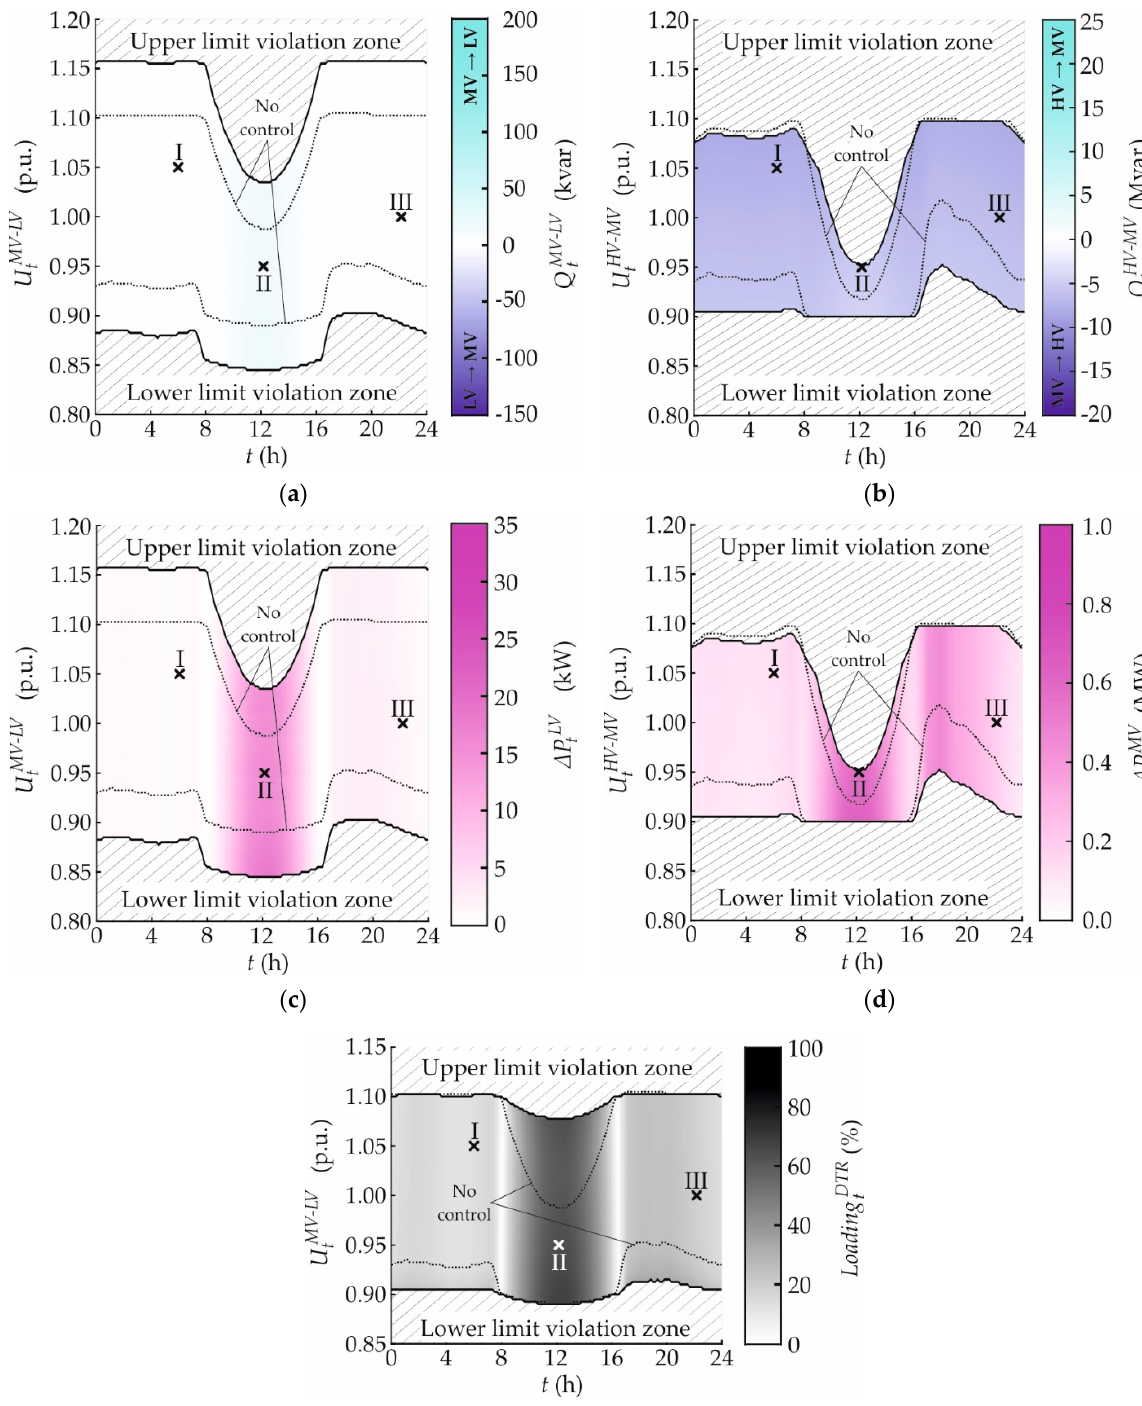
Figure 20. Daily behavior of the test link chain for various boundary voltages, the X ( U ) local control, and CP_ Q -Autarky: ( a ) reactive power exchange over the MV − LV boundary (rural LV_Link-Grid); ( b ) reactive power exchange over the HV − MV boundary; ( c ) active power loss within the rural LV_Link-Grid; ( d ) active power loss within the MV_Link-Grid; ( e ) DTR loading (rural LV_Link-Grid).